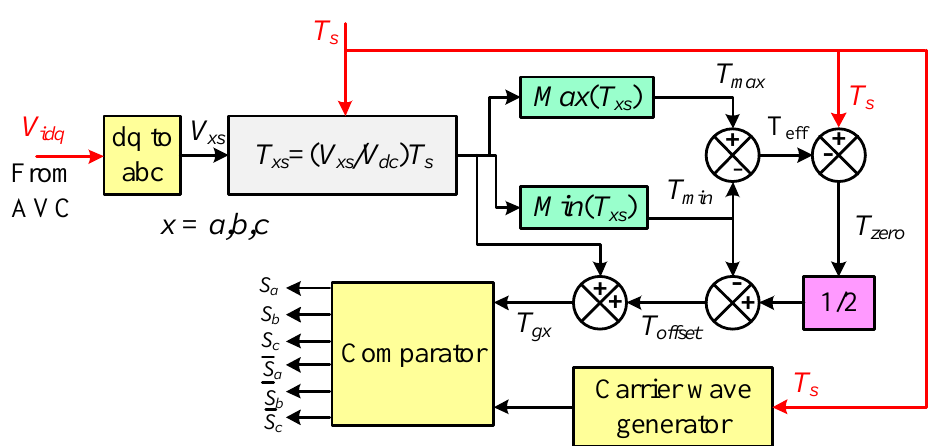
Figure 4. Block diagram for the implementation of the UVSVPWM technique.